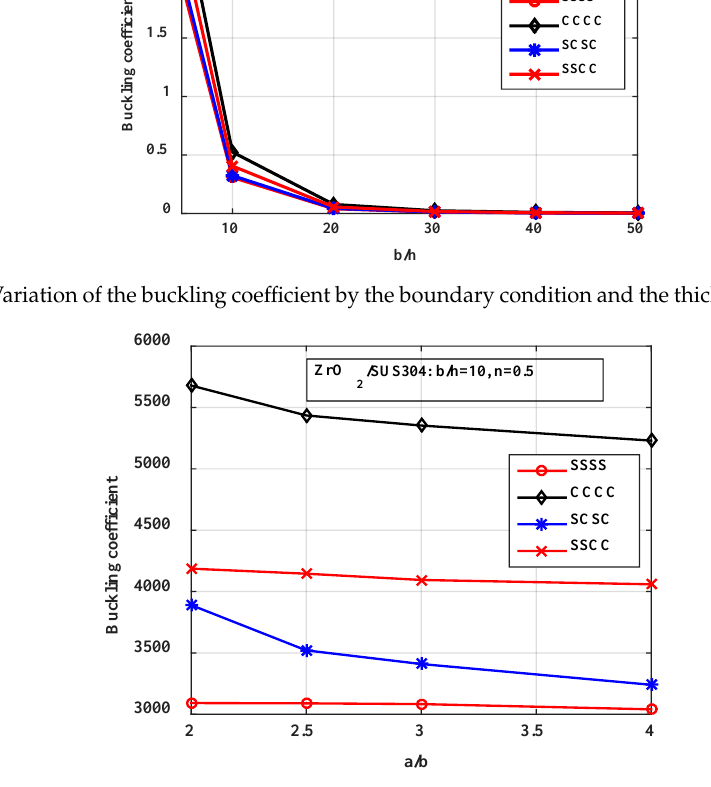
Figure 12. Model of the plate with two parallel stiffeners.